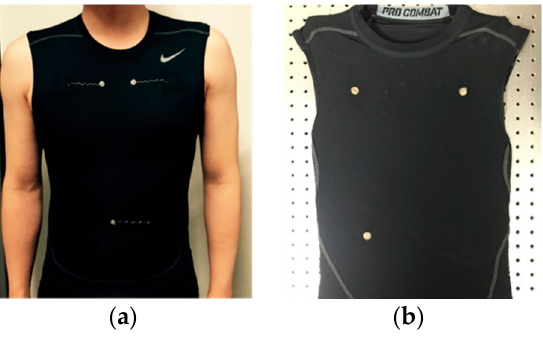
Figure 2. Electrocardiogram (ECG) measurement garment. ( a ) Outside of the garment; and ( b ) inside of the garment.